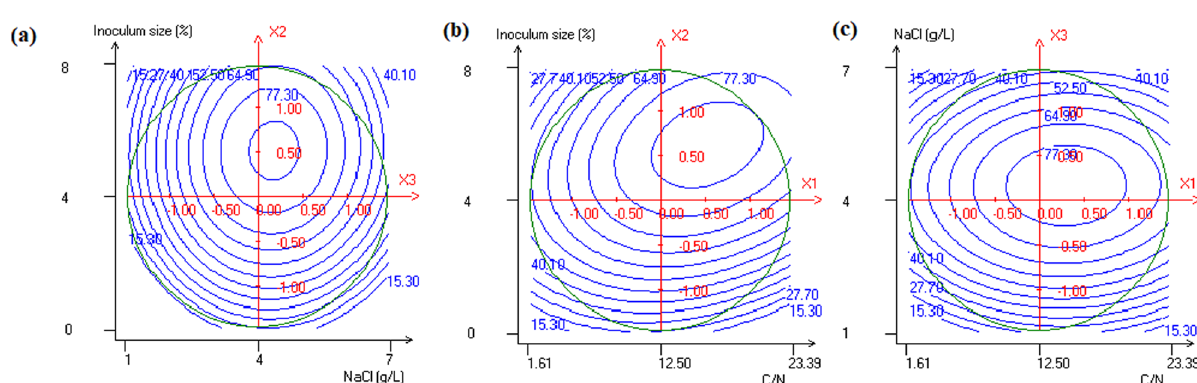
Figure 2. Contour plots of insecticidal activity showing interactive effects of (a) inoculum size and NaCl, (b) inoculum size and C/N, (c) NaCl and C/N. The third parameter is at his central